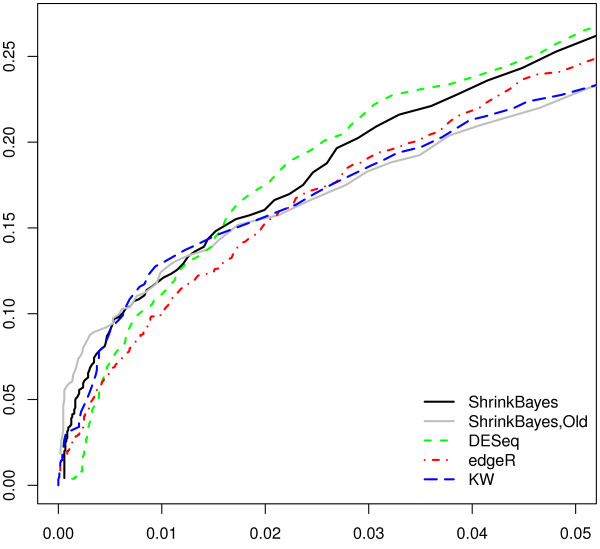
ROC curves for multi-parameter inference: mean False Positive Rate (FPR; x-axis) vs mean True Positive Rate (TPR; y-axis), as averaged over 10 repeats of the data-based simulation, which consists of 3 groups with 5 counts for ≈2000 features.